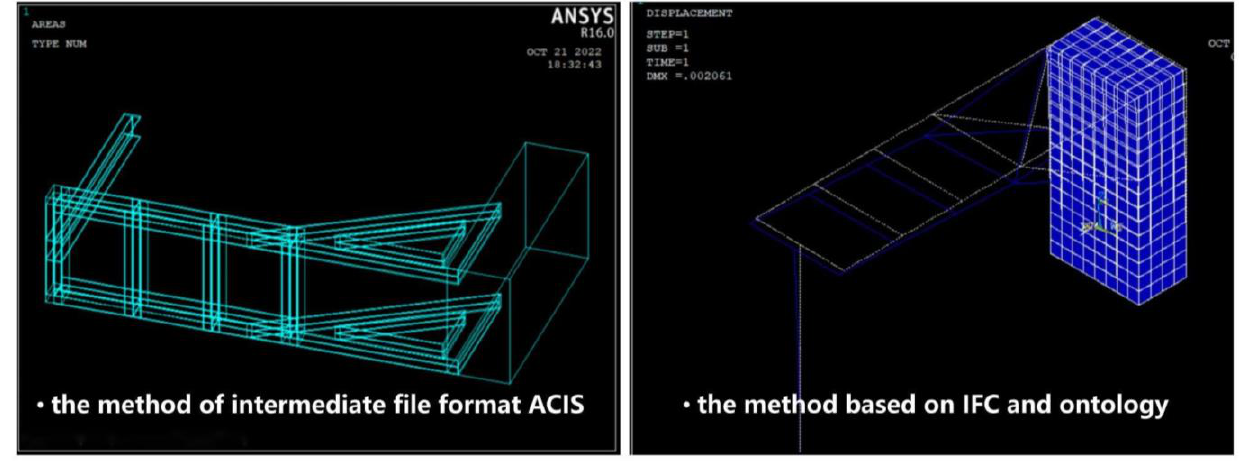
Figure 8. Comparative result.